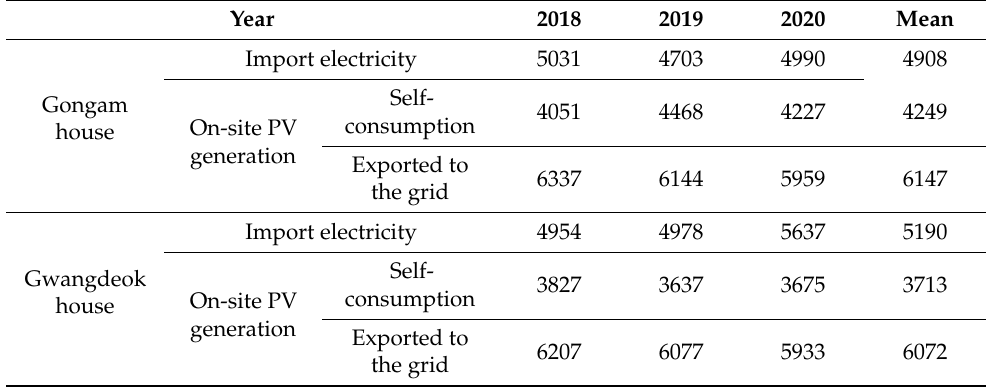
Table 4. Electricity distribution. (Unit: kWh).